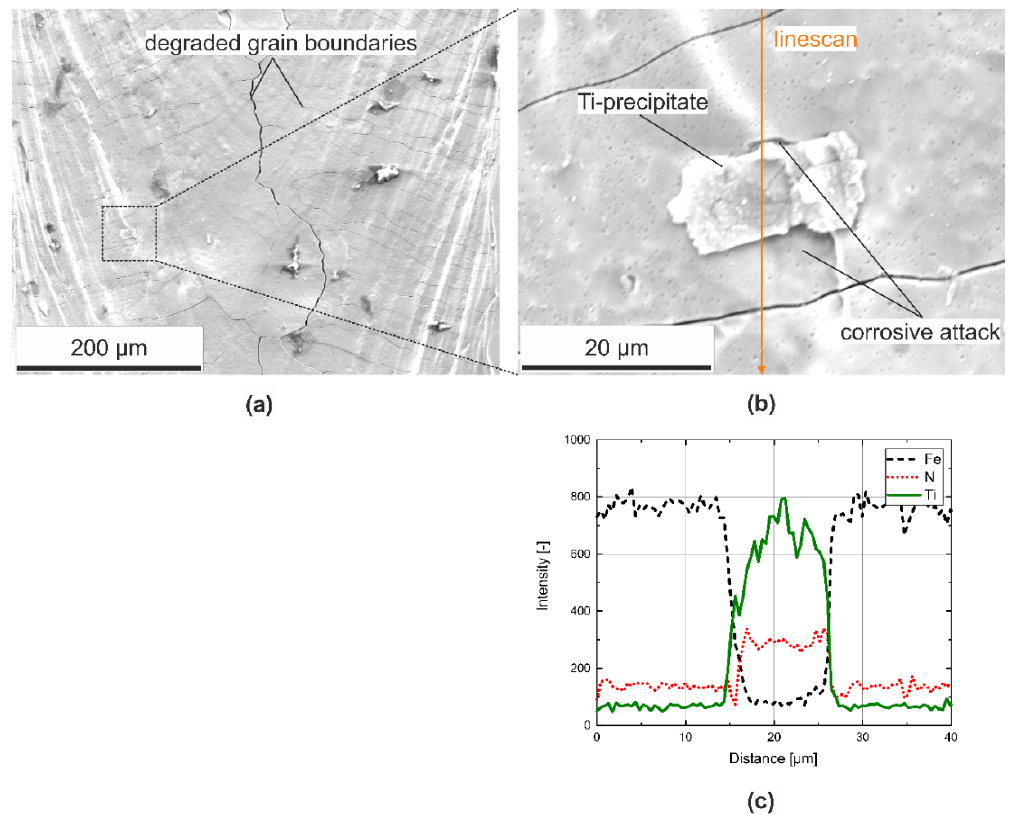
Figure 6. ( a ) SEM overview of the AISI 430Ti welding bead following exposure to 16% boiling sulfuric acid for a duration of 20 h, ( b ) detailed SEM image of a precipitate on top of the welding bead and ( c ) EDS linescan across the identified precipitate.